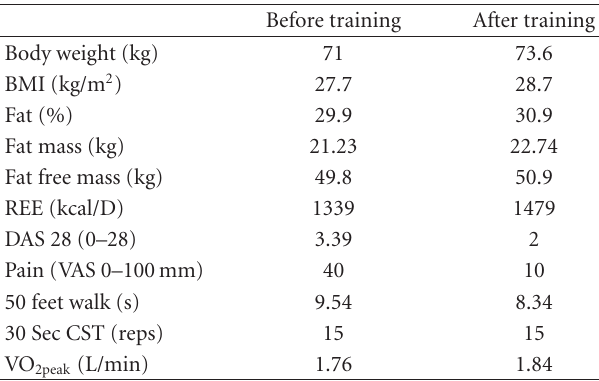
Table 1: Physical characteristics.